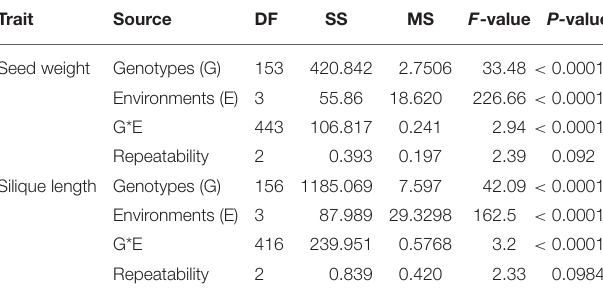
TABLE 1 | Phenotypic variation and analysis of variance (ANOVA) of seed weight and silique length in the association panel. Trait